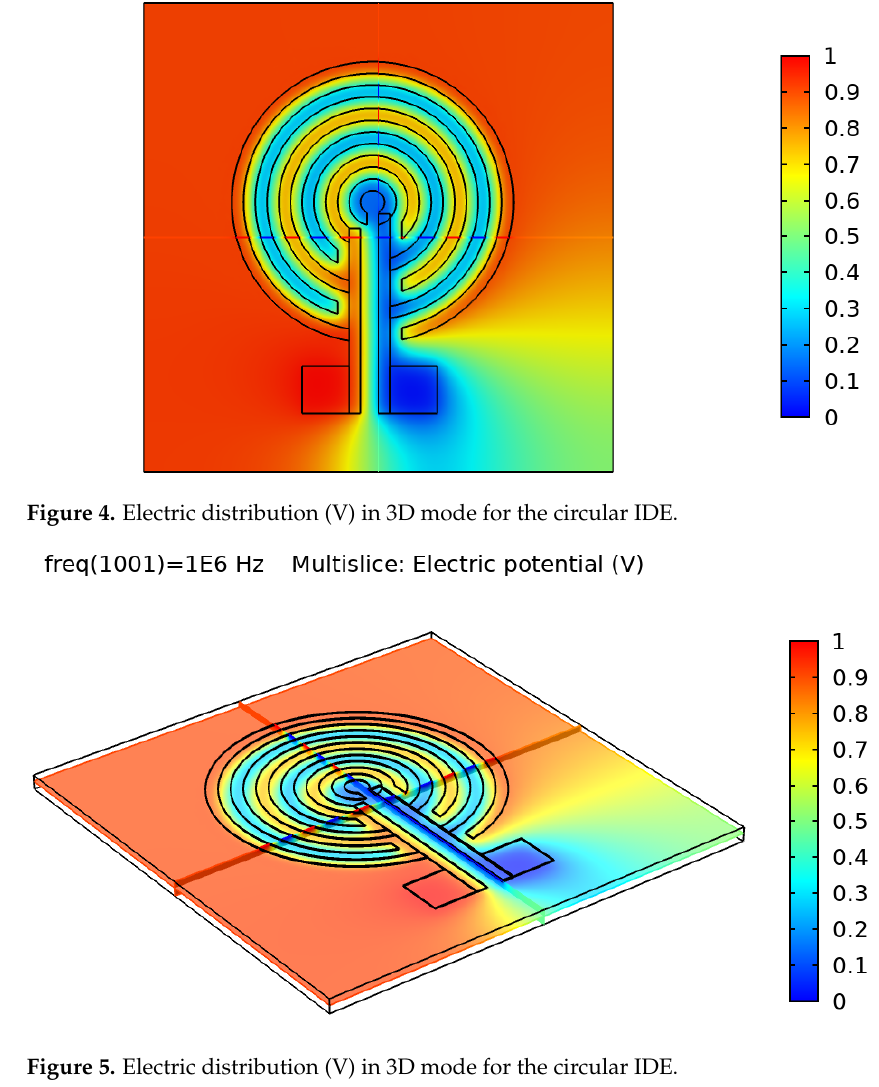
Figure 5. Electric distribution (V) in 3D mode for the circular IDE.